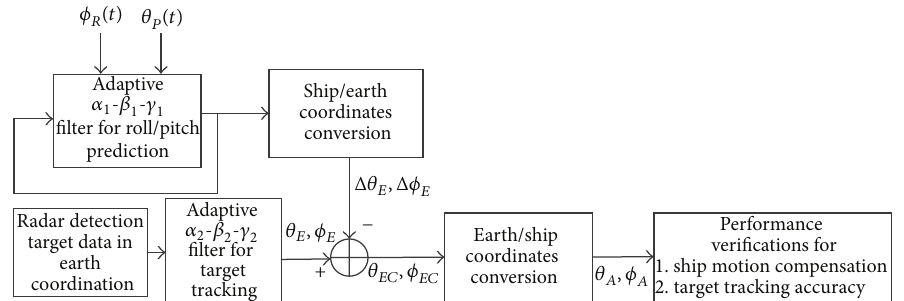
Figure 1: High level structure of ship rotational motion compensation for phased array